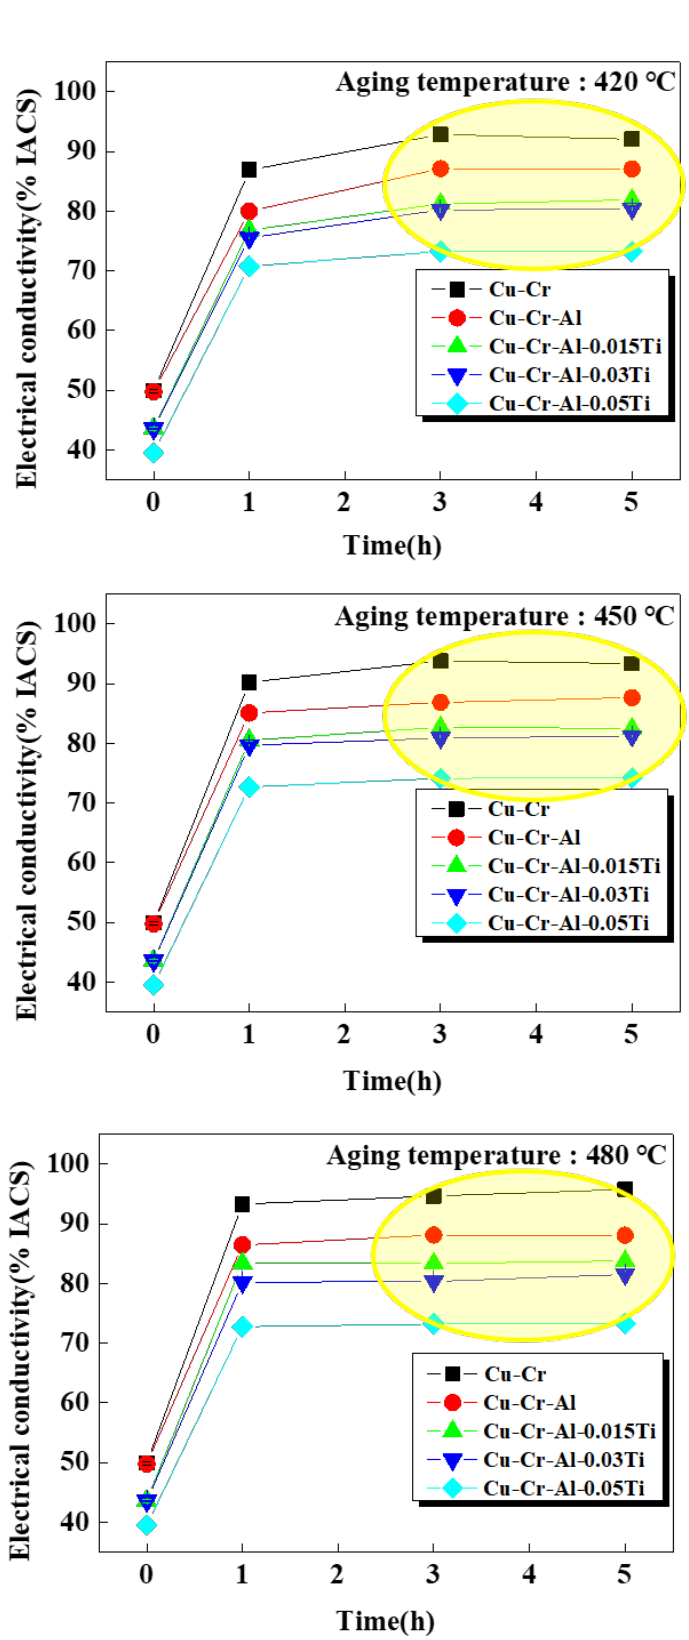
Figure 7. Variation of electrical conductivity of Cu-Cr alloys after aging treatment.